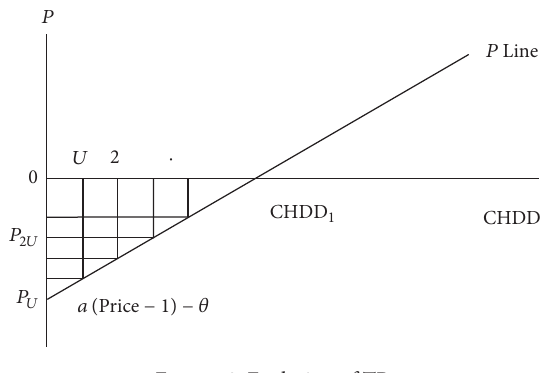
Figure 3: Evolution of